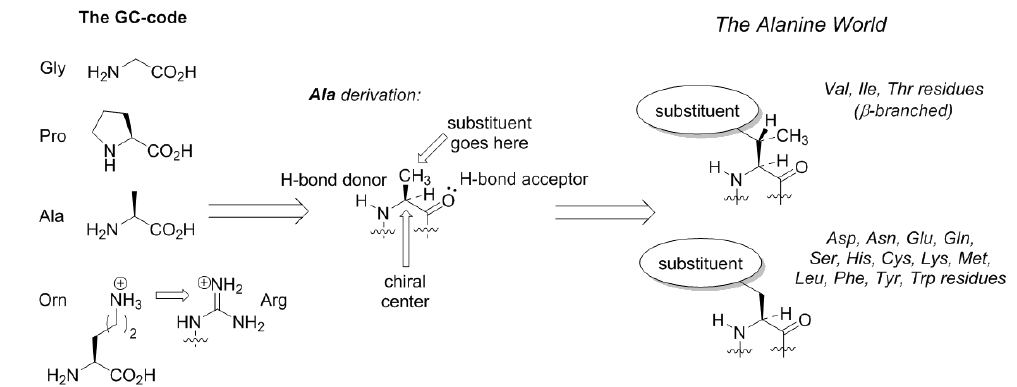
Figure 3. The development of the amino acid structures towards the Alanine